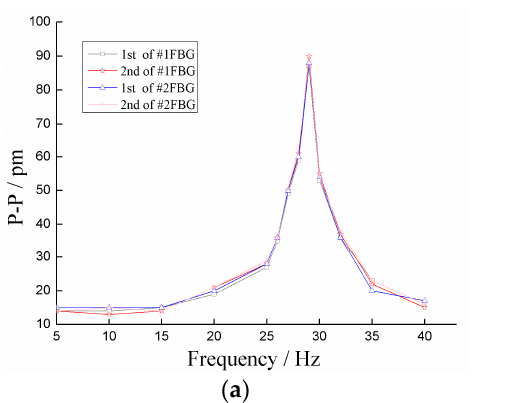
( b ) Figure 9. Time domain and spectrum map of ( a ) #1 mass ball and ( b ) #2 mass ball optical fiber systems. 4.2. Sensitivity Experiments In the experimental system shown in Figure 7, the exciter provides the torsional vibration signal for the shaft, the beam is in the horizontal position, and the distance between the excitation point on the beam and the axis of the shaft d is 305 mm. If the excitation acceleration of the exciter is a , the torsional vibration acceleration β would be a/d . During the experiment, the frequency of excitation acceleration was always kept at 2 Hz, the excitation acceleration amplitude increased from 5 to